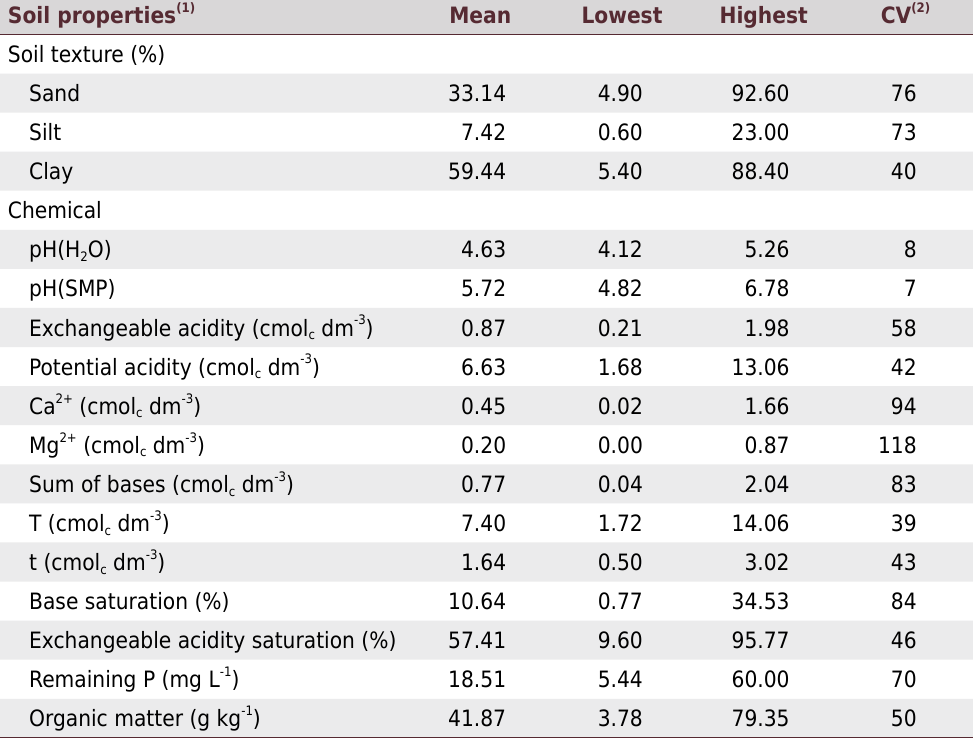
Table 3. Descriptive statistics for soil texture and chemical properties of the soils used in the lime incubation study Soil properties